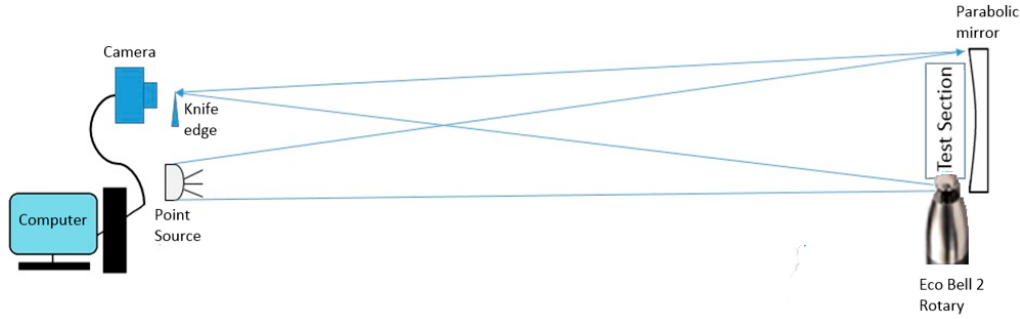
Figure 1. Schematic diagram of the Schlieren setup for SA visualization.